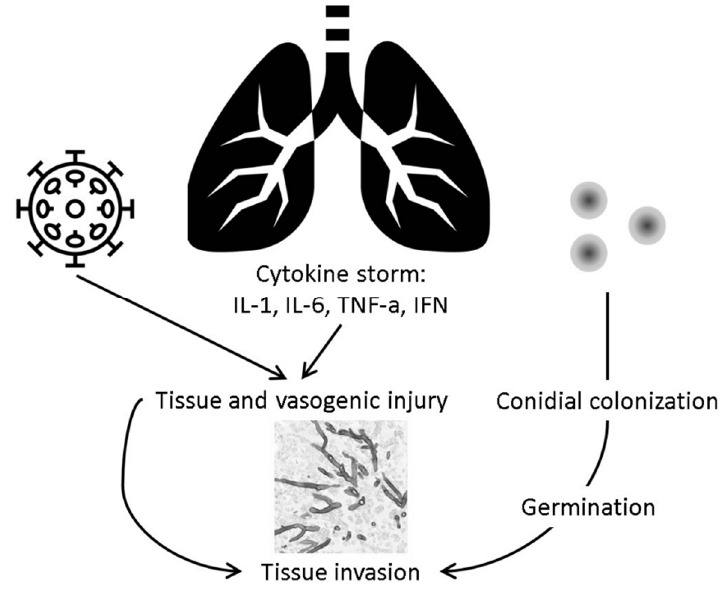
Figure 1. Proposed pathogenesis of CAPA.